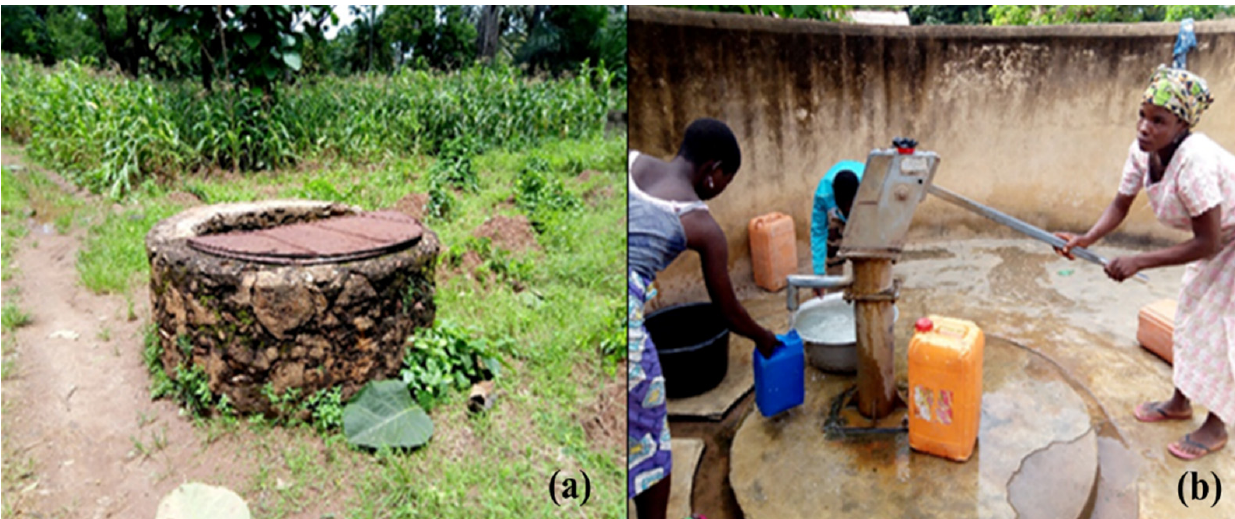
Figure 4. Traditional sinks exploiting the water of the alterite reservoir at Niamtougou (northwest of the study zone) ( a ) and borehole equipped with a human-operated pump, exploiting the water of the fractured reservoir at Bébéda (center of the study zone) ( b ).